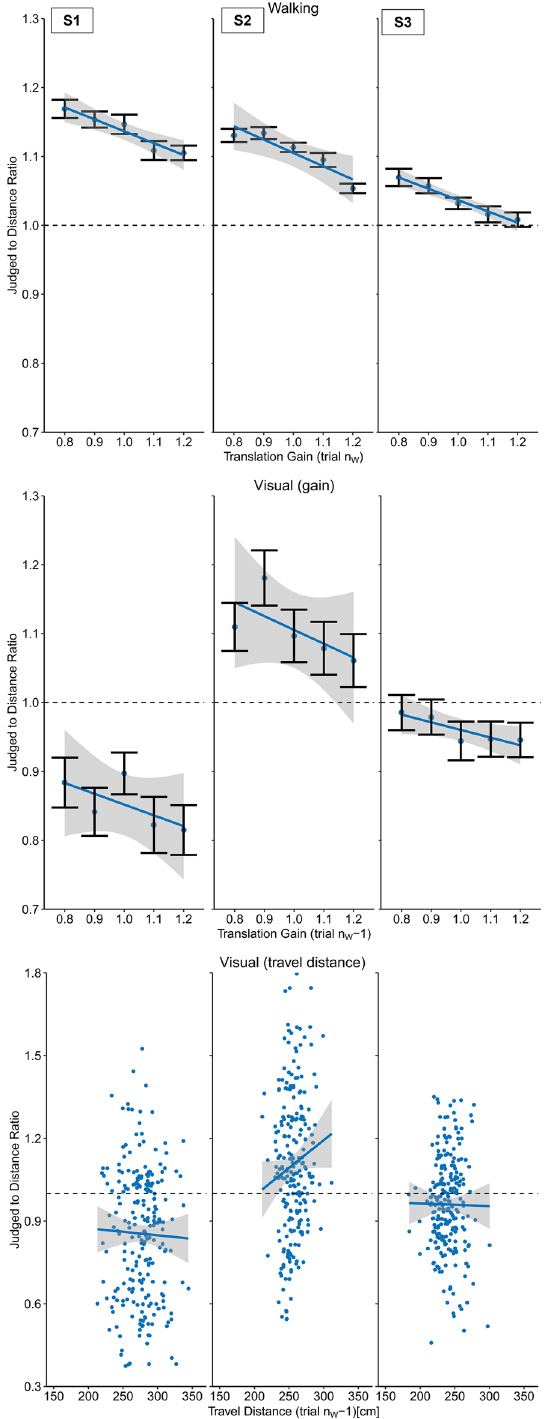
Figure 3. Results of Experiment 1 (physical walking with optic flow) for three example participants. Upper panel: Regression between the translation gain in trial n W and judge to distance ratio for walking distance estimations in trial n W . Middle panel: Serial dependencies quantified by the regression between the translation gain in in trial n w − 1 and visual distance judgements. Lower panel: Serial dependencies quantified by the regression between travel distance in trial n w − 1 and visual distance judgements. Error bars represent the SEM and the grey areas represent the 95% confidence